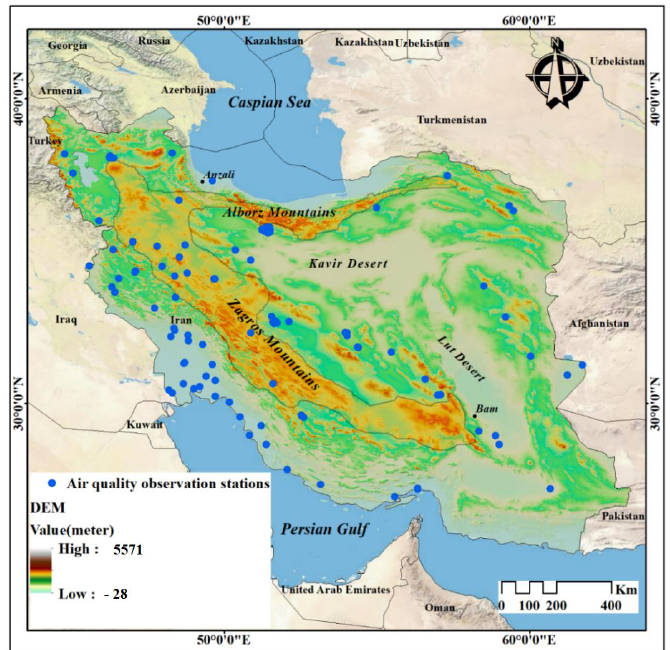
Figure 1. Study area.